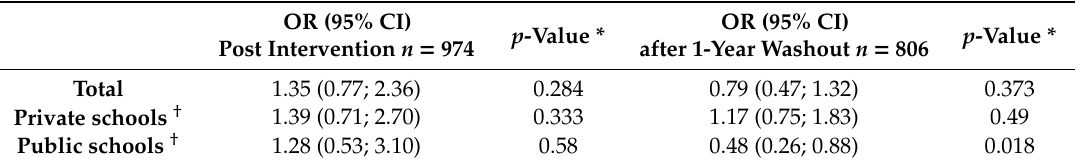
Table 3. Odds ratio of overweight / obesity change in intervention vs. control groups¶ post-intervention and after